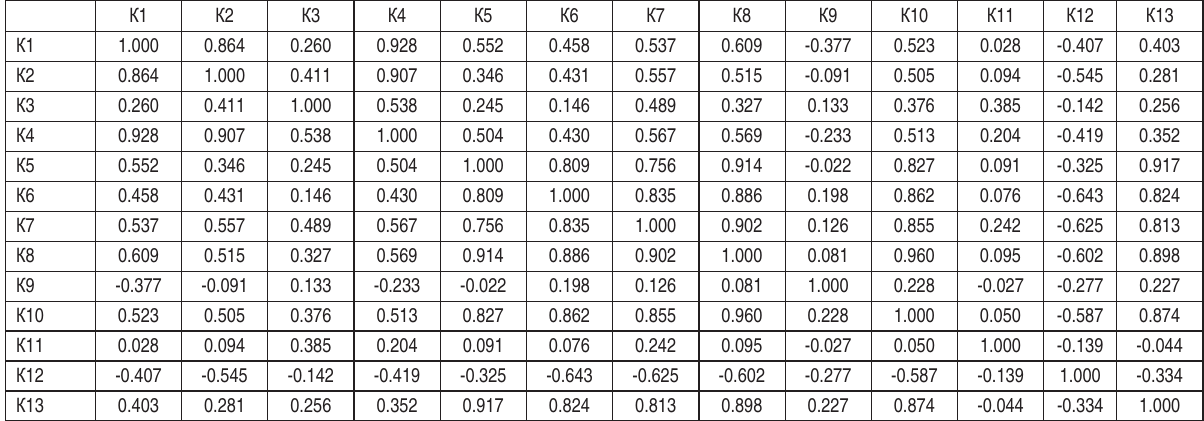
Table 3. Correlation matrix